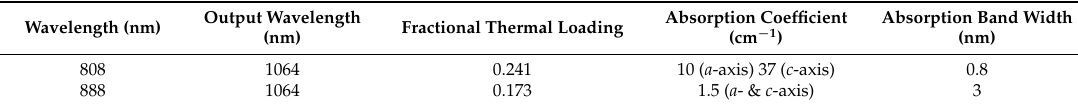
Table 1. Comparison of Nd:YVO 4 pumped by 808 nm and 888